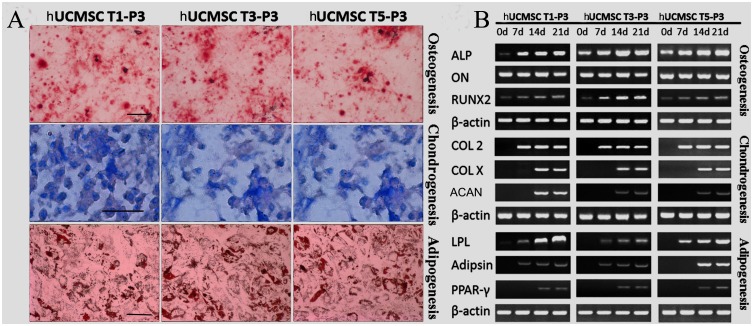
Multilineage differentiation capacities of the T1-P3, T3-P3 and T5-P3 hUCMSCs were confirmed by histochemical staining (A) and RT-PCR (B).(A) The formations of mineralization nodes, lipid-rich vesicles, and a cartilaginous extracellular matrix (sulfated proteoglycans) were revealed by Alizarin red, Oil Red O, and Alcian blue staining, respectively. (B) Additionally, cells were harvested for RT-PCR. LPL, lipoprotein lipase; hUCMSCs, human umbilical cord-derived mesenchymal stromal cells. Scale bars: 25 µm in A.